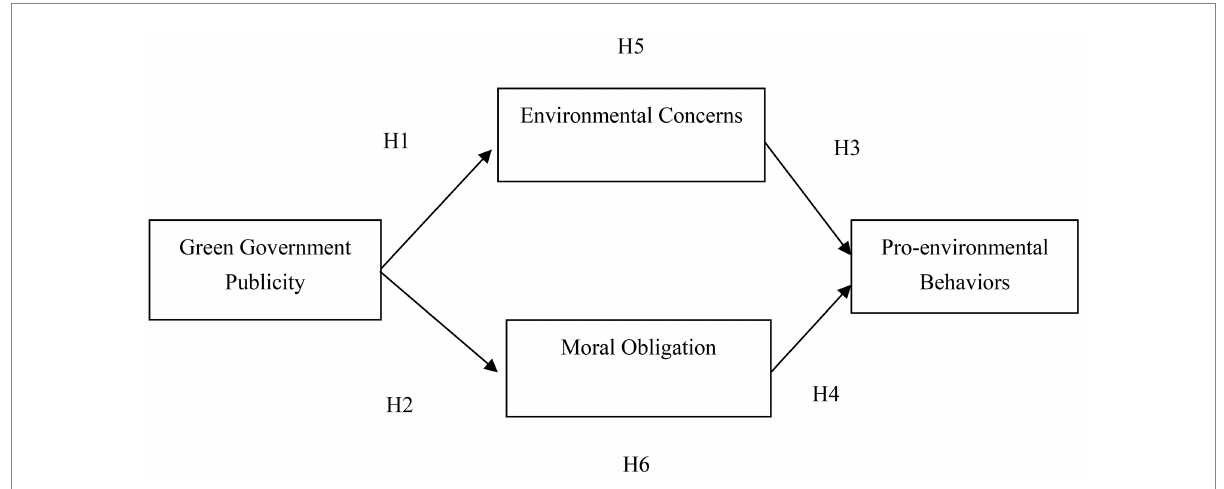
FIGURE 1 Conceptual